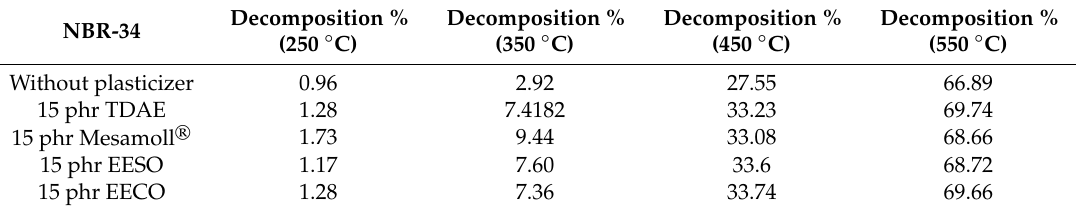
Figure 12. TGA thermograms of NBR-34 vulcanizates with various plasticizers. Table 3. Results of TGA of NBR-34 vulcanizates with various plasticizers.